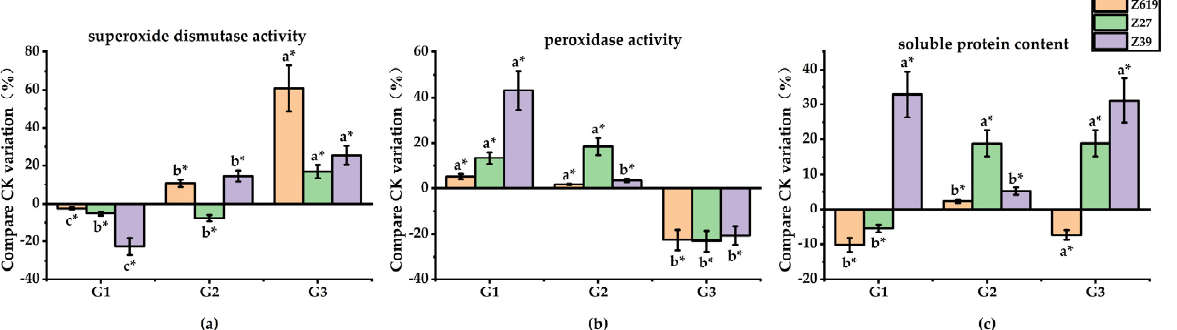
Figure 4. ( a ) Effects of different concentrations of gibberellin on superoxide dismutase activity in root system; ( b ) Effects of different concentrations of gibberellin on peroxidase activity in roots; ( c ) Effect of different concentrations of gibberellin on soluble protein content in roots. * Different lowercase letters in the figure indicate that different treatments of the same variety have significant differences at p < 0.05.